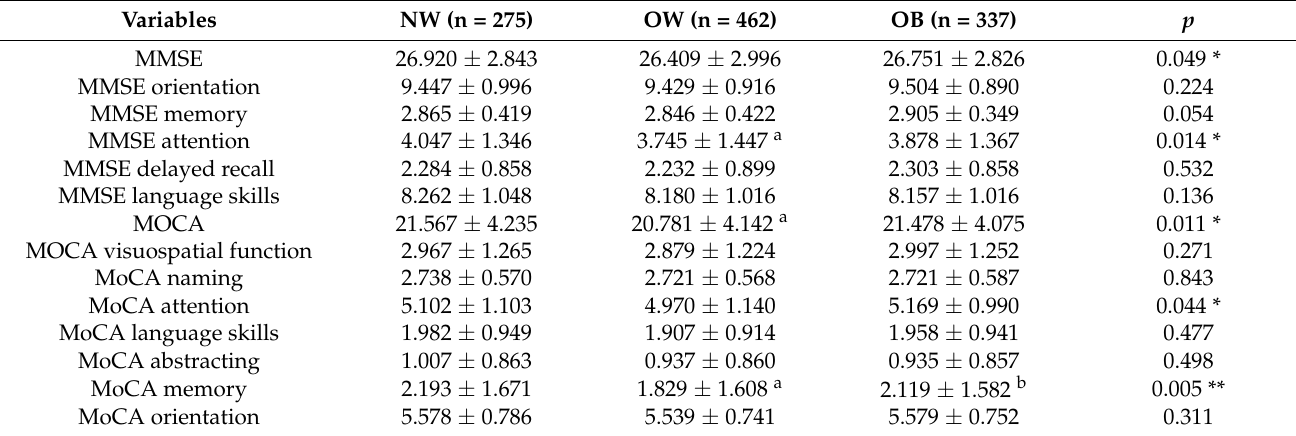
Table 3. Cognitive score of the study population in the three groups.